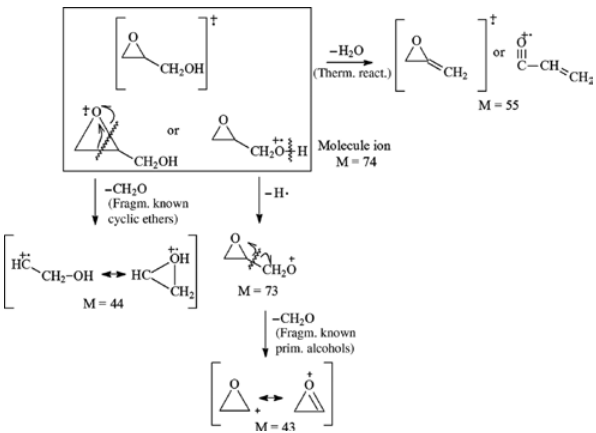
Figure 7: Possible fragmentation path of glycidol radical cation.